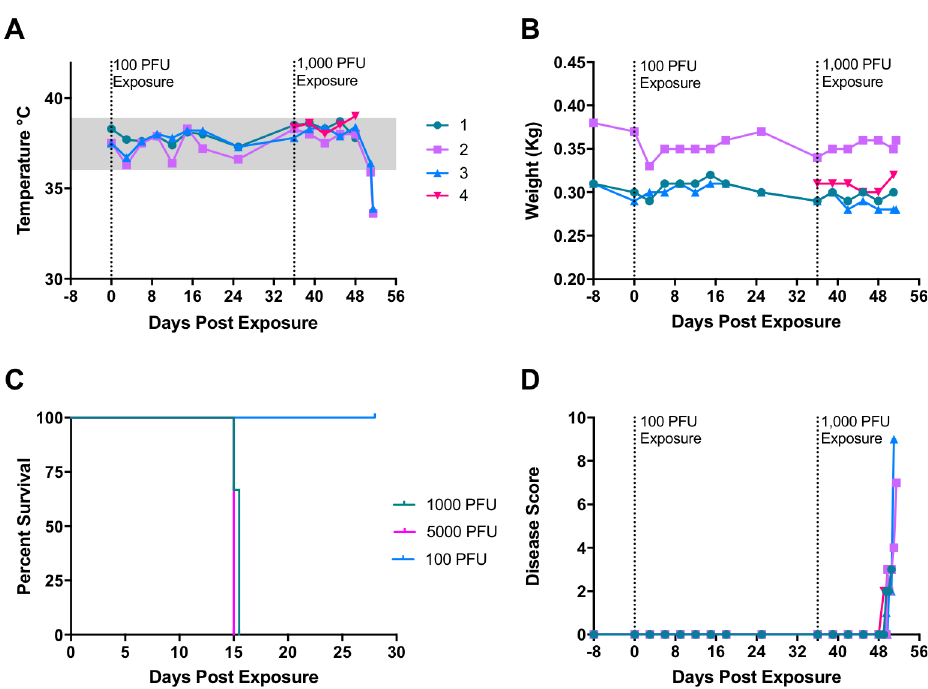
Fig 1. Clinical assessment of marmosets exposed to monkeypox virus. Animal 1–3 were exposed once on Day 0 with an intranasal dose of 100 PFU and subsequently re-exposed with 1000 PFU on day 36. Rectal temperature, (A), and body weight (B), were evaluated every 3 days under sedation. Survival outcome, (C). Animals were evaluated for recumbence, unresponsiveness, and dyspnea and given a disease score, (D). Three males (#1, #2, and #4) and one female (#3) were used in this